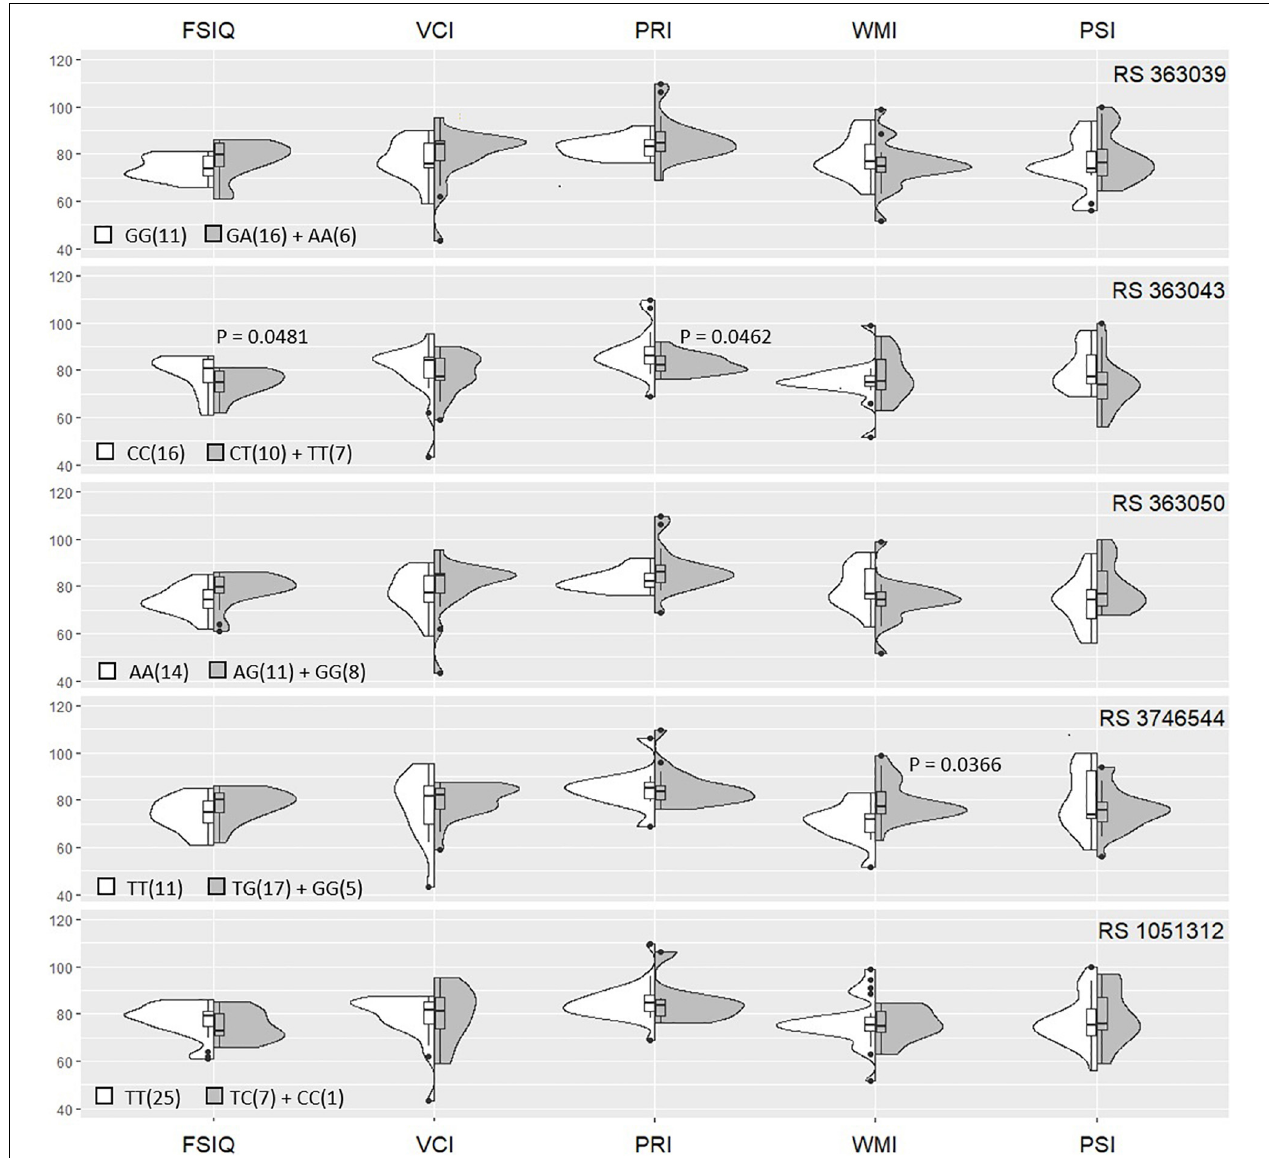
FIGURE 1 | Violin plots of Kernel’s smoothed distributions of WISC-III/IV scores by SNAP-25 genotypes. The box plots present the distribution of each IQ score (median and interquartile range) relatively to the genotype distribution. The “violin” area indicate the percentage of children with BIF for each allele (in gray the minor allele and white the major